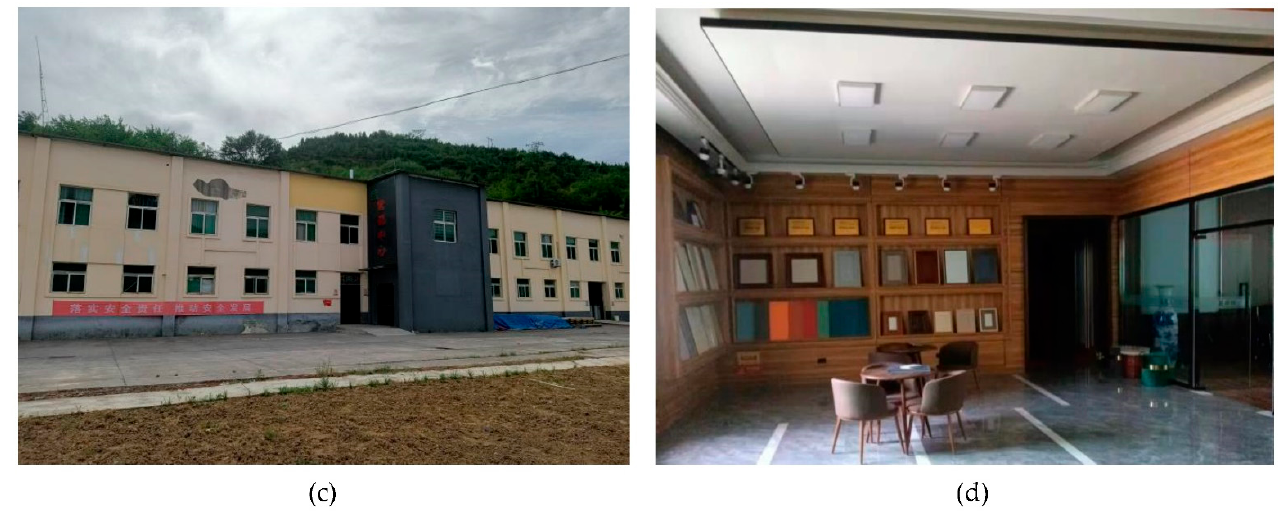
Figure 9. Renovation of idle workshops. As shown in Figure 9, Youfangtou Village renovated a coal mine that had been idle for 8 years and leased it to two local start-up companies returning home as offices and production sites. The village collective can collect rents of more than CNY 200,000 per year. ( a , b ) show the production workshop transformed from the idle factory. ( c ) shows the remodeled appearance of the idle factory building. ( d ) Shows the office converted from vacant factory building. The pictures were taken by the co-author Yuanyuan Zhang.